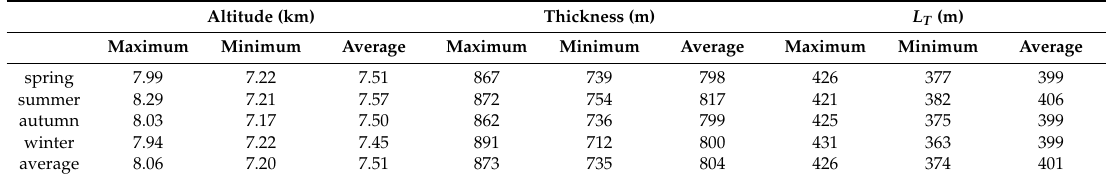
Table 2. Statistical characteristics of SMLT of 2007 after meridional averaging. Altitude (km) Thickness (m) L T